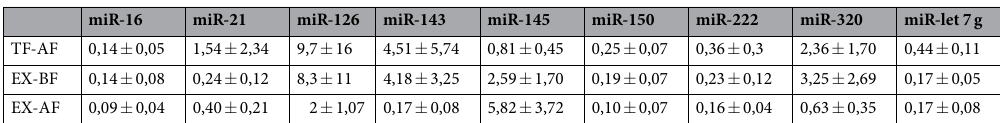
Table 3. Coefficient of variance between the 4 consecutive visits. Abbreviation . AF: after freezing, BF: before